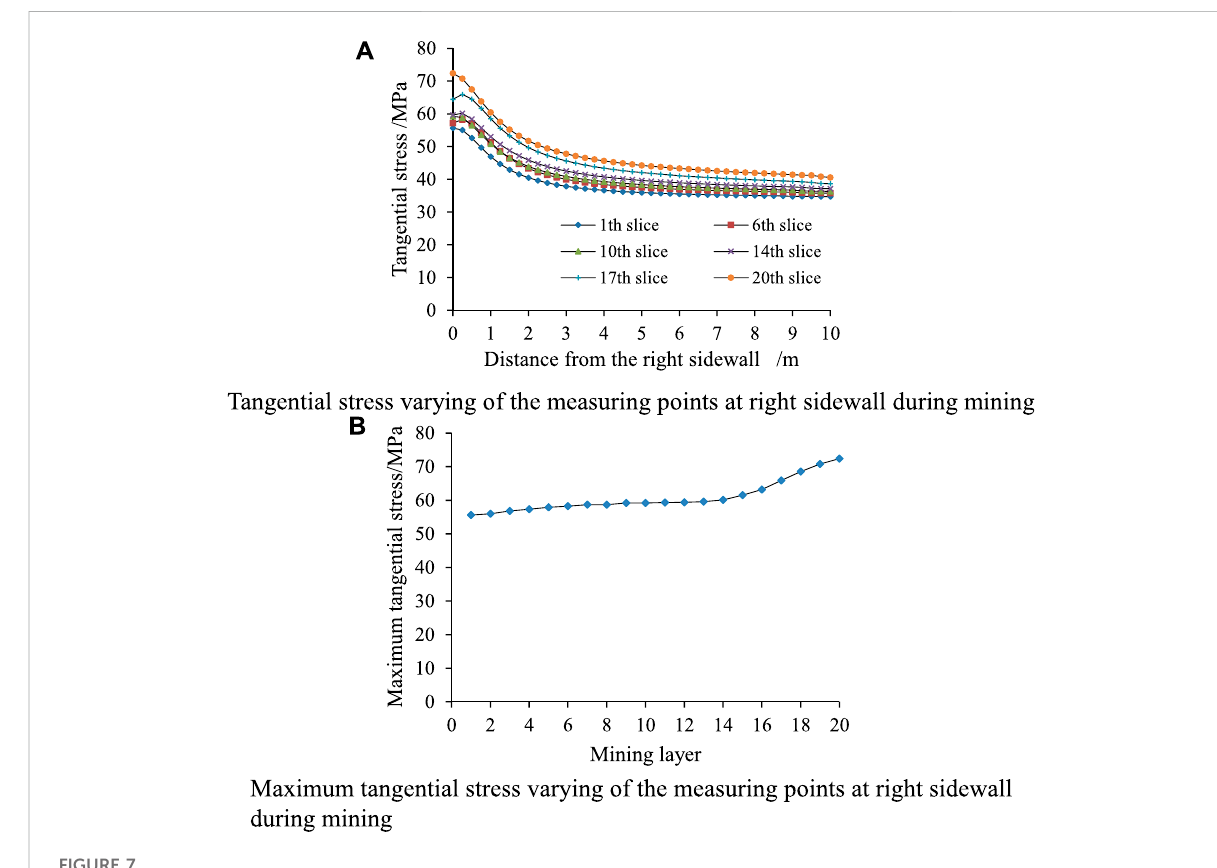
FIGURE 7 Tangential stress varying at right sidewall during mining.